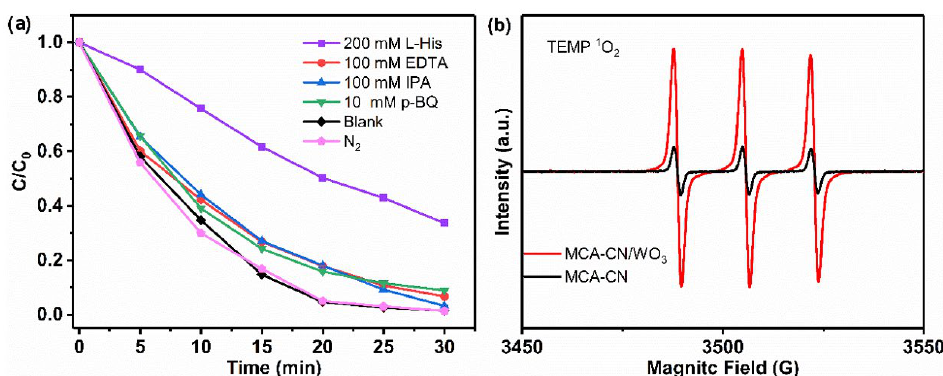
Figure 11. ( a ) Quenching experiment of different radicals and ( b ) EPR spectra for TEMP adducts in photo-Fenton-like system of MCA-CN and MCA-CN/WO 3 .